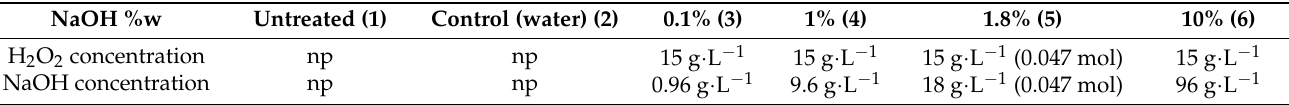
Table 1. NaOH concentration variation during H 2 O 2 treatment.